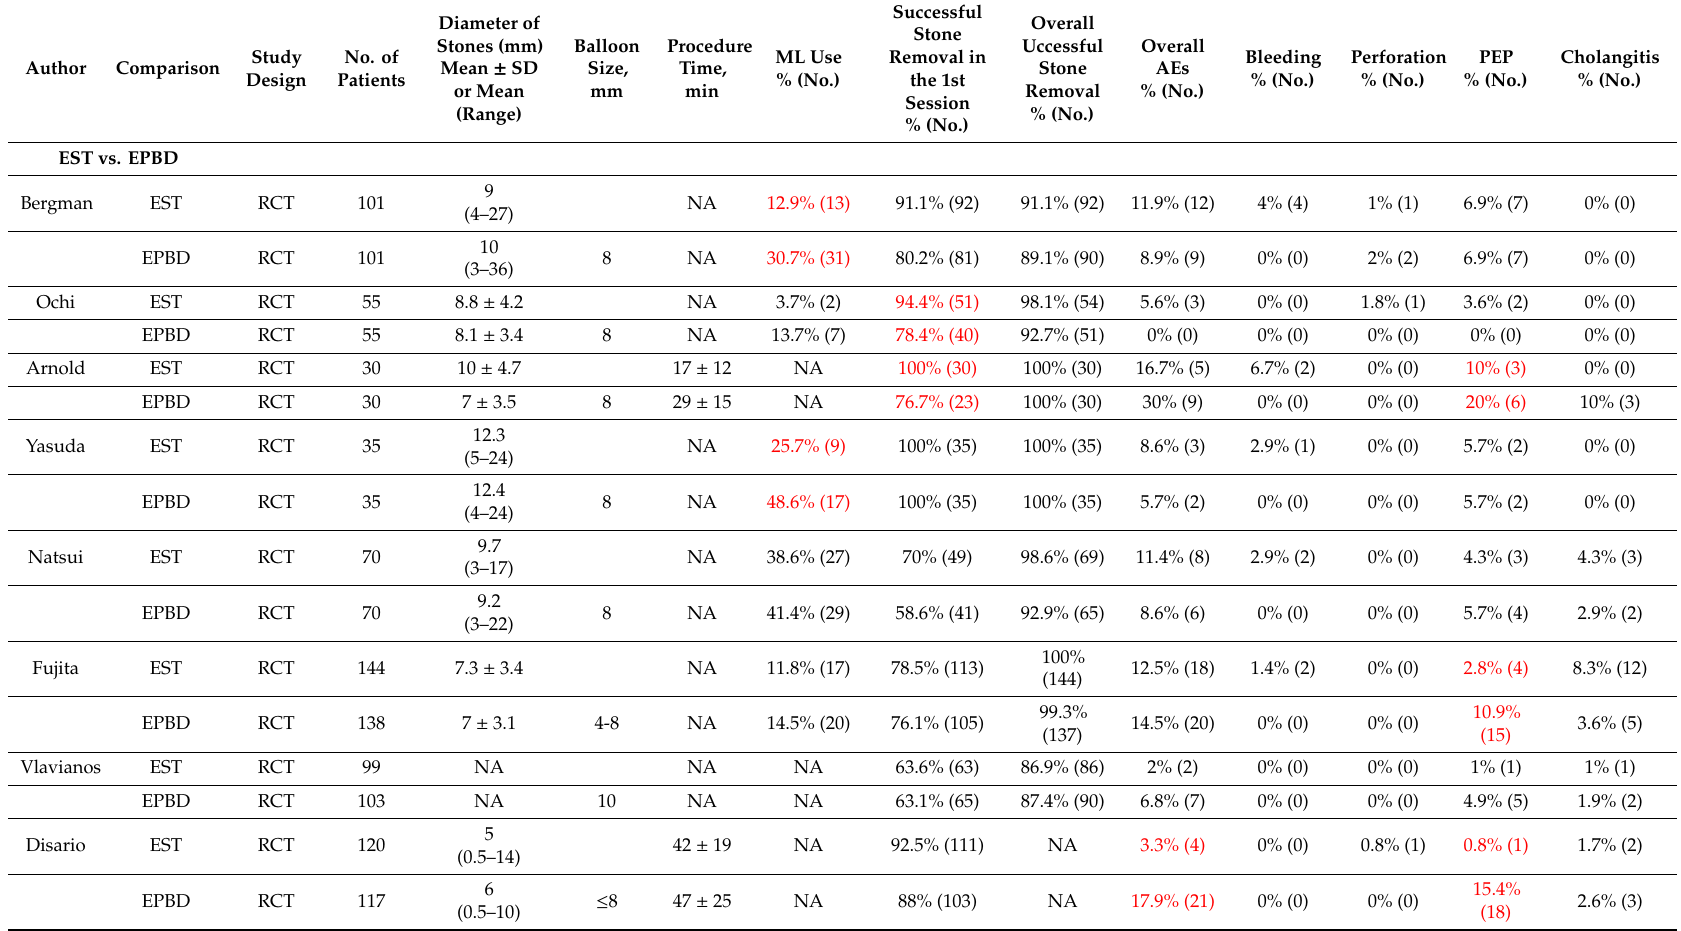
Table 2. Baseline characteristics, procedural outcomes and adverse events of the included studies for small common bile dust